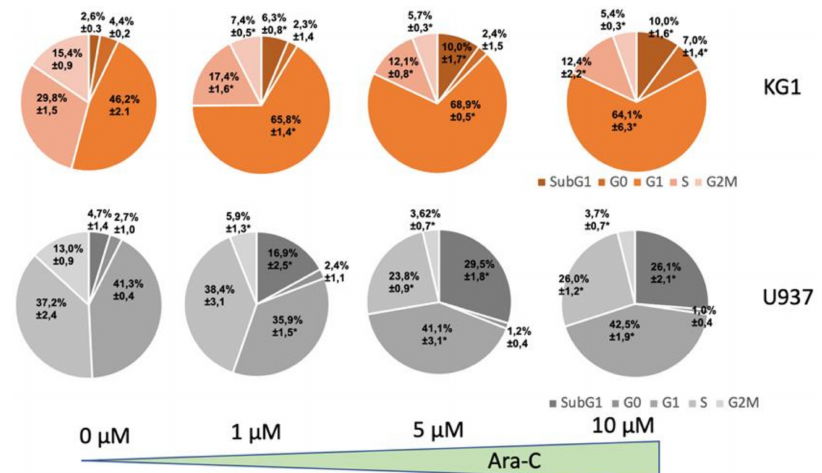
Figure 7. Effect of Ara-C on the KG1 and U937 cell cycle. Cell cycle analysis by flow cytometry of KG1 and U937 AML cell lines with KI67/PI double staining. Cells were either in a control condition or treated with Ara-C at the indicated concentrations for 24 h. Three independent experiments were performed. * p ≤